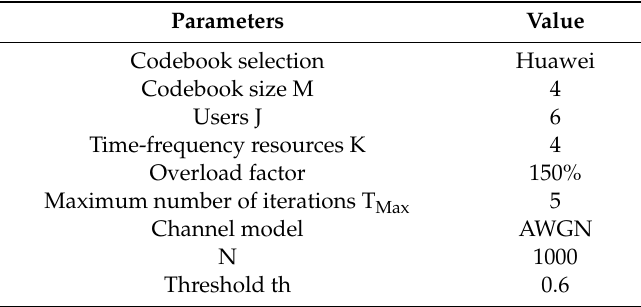
Table 1. Simulation parameters.